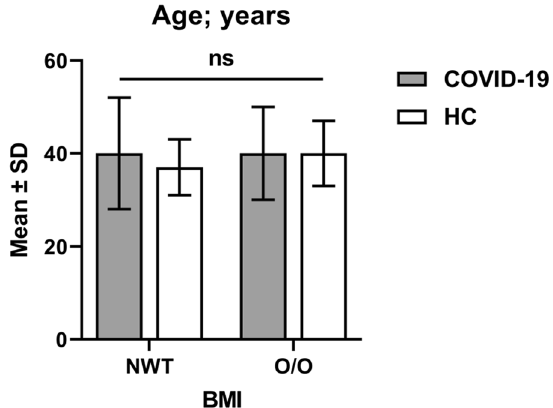
Fig. 1 Column-bar plot of age in COVID-19 patients and healthy controls (HC) stratified by body mass index (BMI). Columns represent mean. Bars represent standard deviation (SD). Significant difference was assessed using one-way analysis of variance (ns: p -value is not significant; > 0.05). The mean age was 40 normal-weight individuals (NWT) and 40 overweight/obese (O/O) individuals from COVID-19 patients and HC, respectively. The difference between the means was not significant ( p =